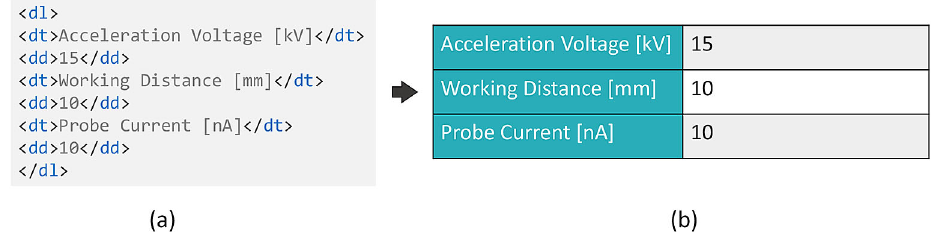
Figure 5. HTML description list rendering in eLabFTW. (a) Title-value pairs in the HTML description list format, and (b) the rendered description list with a custom CSS styling. CSS, Cascading Style